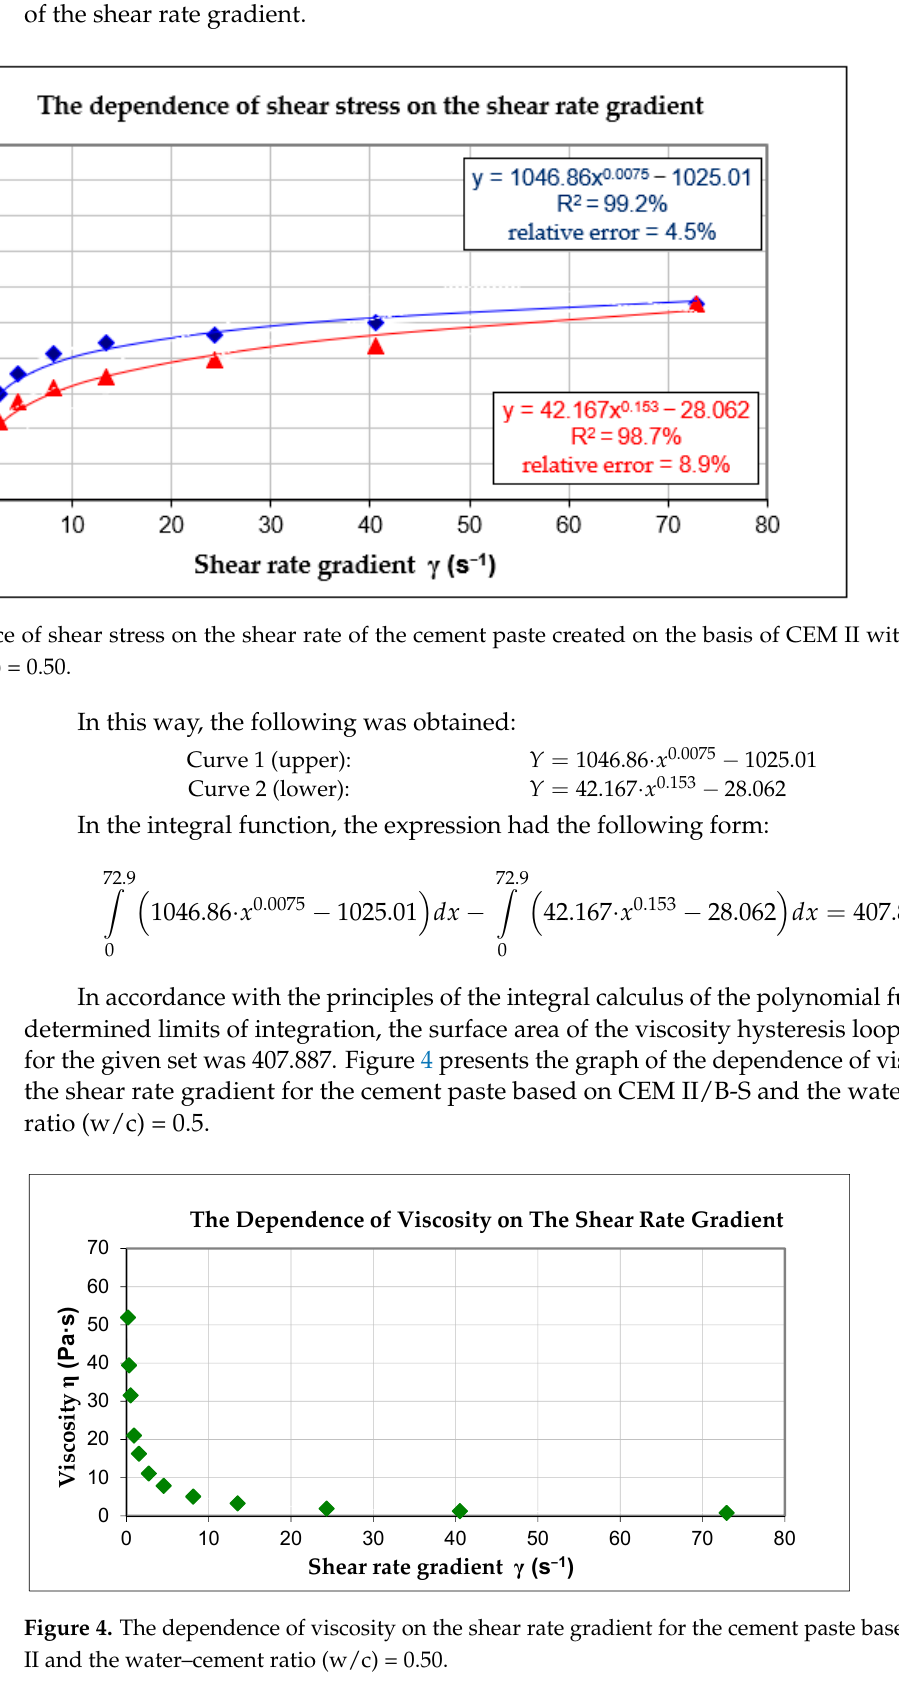
Figure 4. The dependence of viscosity on the shear rate gradient for the cement paste based on CEM II and the water–cement ratio (w/c) = 0.50. The results of the performed studies for two types of cement and for various water– cement ratios (w/c) in the scope of the dependence of the viscosity of the cement paste on the type of cement and the water–cement ratio (w/c) are presented in Table 3.